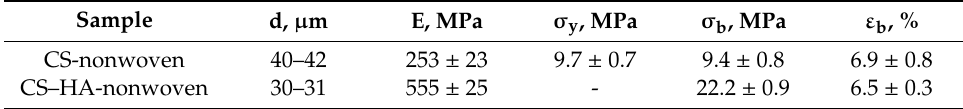
Table 3. Mechanical properties of nonwoven materials, mean ± standard deviation (n =